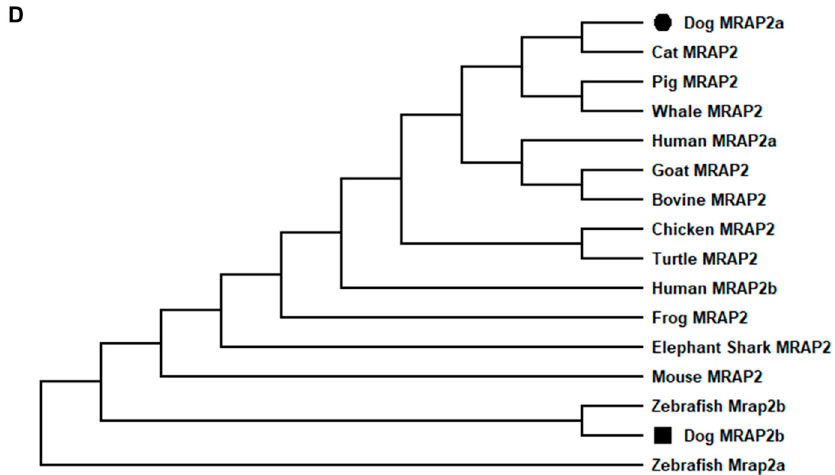
Figure 3. Schematic diagram ( A ), nucleotide and deduced amino acid sequences ( B , cMRAP2a, C , cMRAP2b) and phylogenetic tree ( D ) of MRAP2s . Positions of nucleotide and amino acid sequences are indicated on both sides. N -linked glycosylation sites are present in open boxes. Red box denotes YEYY motif. Light blue box indicates LDYL motif. Black box is LKANKYL motif. Shaded box shows putative TMD. Asterisk (*) shows stop codon. The tree was constructed by the neighbor-joining (NJ) method. Numbers at nodes indicate the bootstrap value, as percentages, obtained for 1000 replicates. Black dot denotes canine MRAP1. MRAP1s: MRAP2s: Canis lupus familiaris (dog MRAP2a, XM_038682814.1; MRAP2b, XM_038682813.1), Mus musculus (mouse NP_001171202.1), Sus scrofa